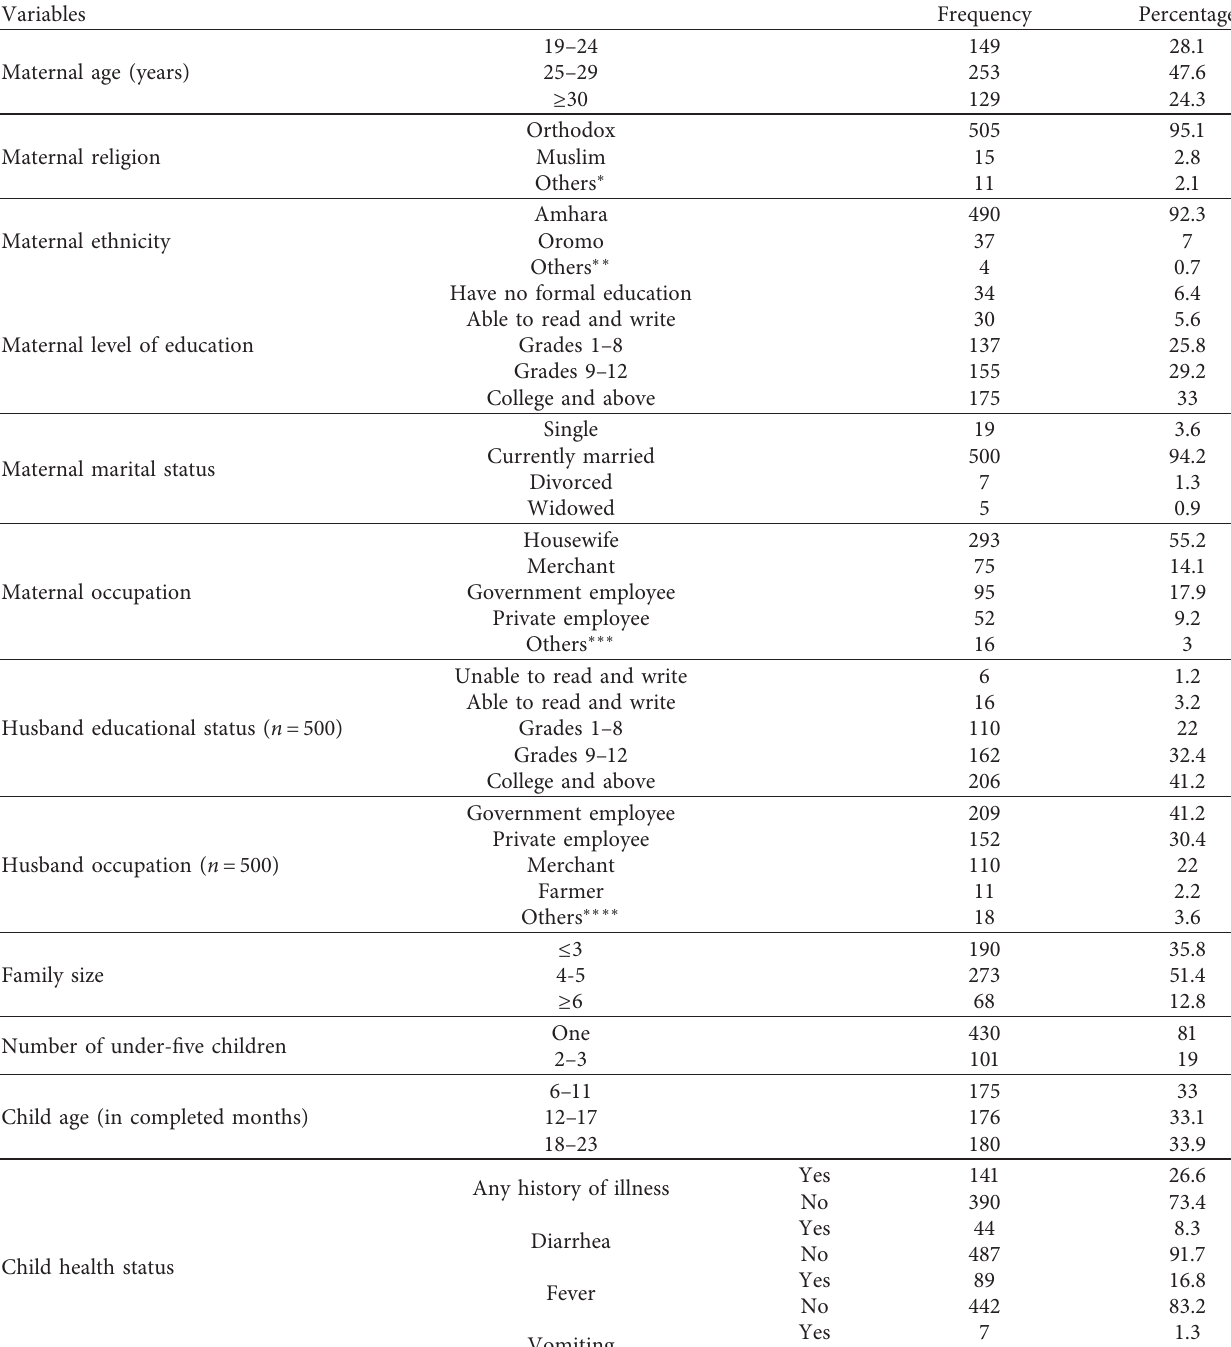
Table 1: Sociodemographic characteristics of mothers/caregivers and infants and young children aged 6–23 months in Debre Berhan Town, North Shewa Zone, 2018 ( n �